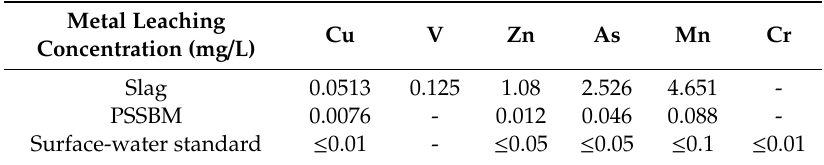
Table 5. Toxic leaching of steel slag and PSSBM.